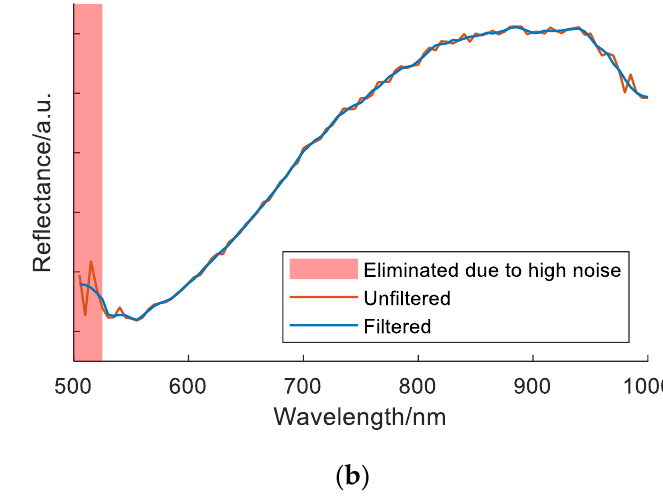
Figure 2. ( a ) HSI spectra were selected (white crosses) within the central fissure near the histological cross-sectional plane (dashed line) and ( b ) preprocessed, including (i) the elimination of wavelengths with high noise (505–525 nm; shaded red) and (ii) filtering of spectra to find the optimal data configuration for classifier training.